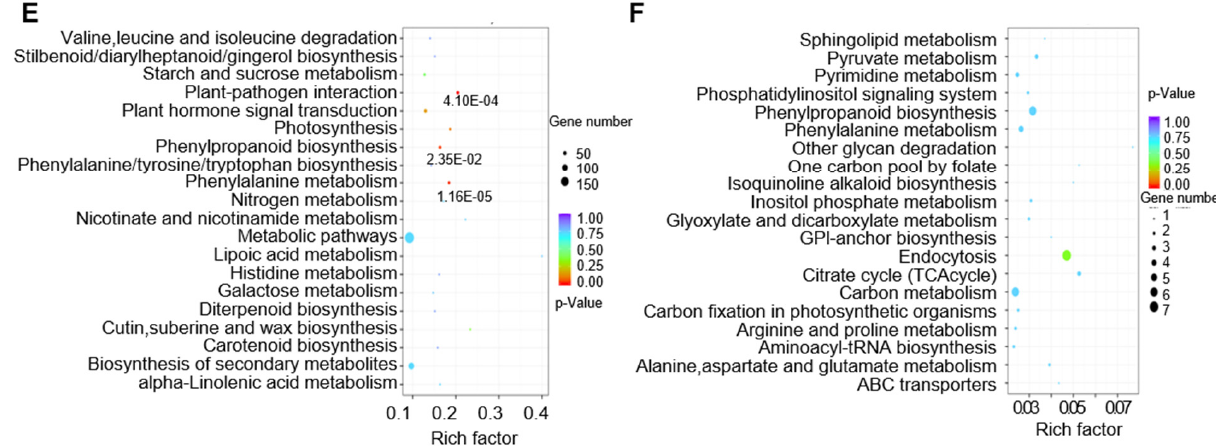
Figure 6. Biological function analysis of genes co-expressed and co-localized with classified lncRNAs. ( A , B ) KEGG analysis of genes co-expressed ( A ) and co-localized ( B ) with lncRNAs whose expression levels consistently increased in fruits from 5dpa to 40dpa, related to Figure 5A. ( C , D ) KEGG analysis of genes co-expressed ( C ) and co-localized ( D ) with lncRNAs whose expression levels consistently decreased in fruits from 5 dpa to 40 dpa, related to Figure 5B. ( E , F ) KEGG analysis of genes co-expressed ( E ) and co-localized (F) with lncRNAs isolated in Figure 5C. GPl, glycosylphosphatidylinositol. The p-value of significantly enriched pathway was marked accordingly.